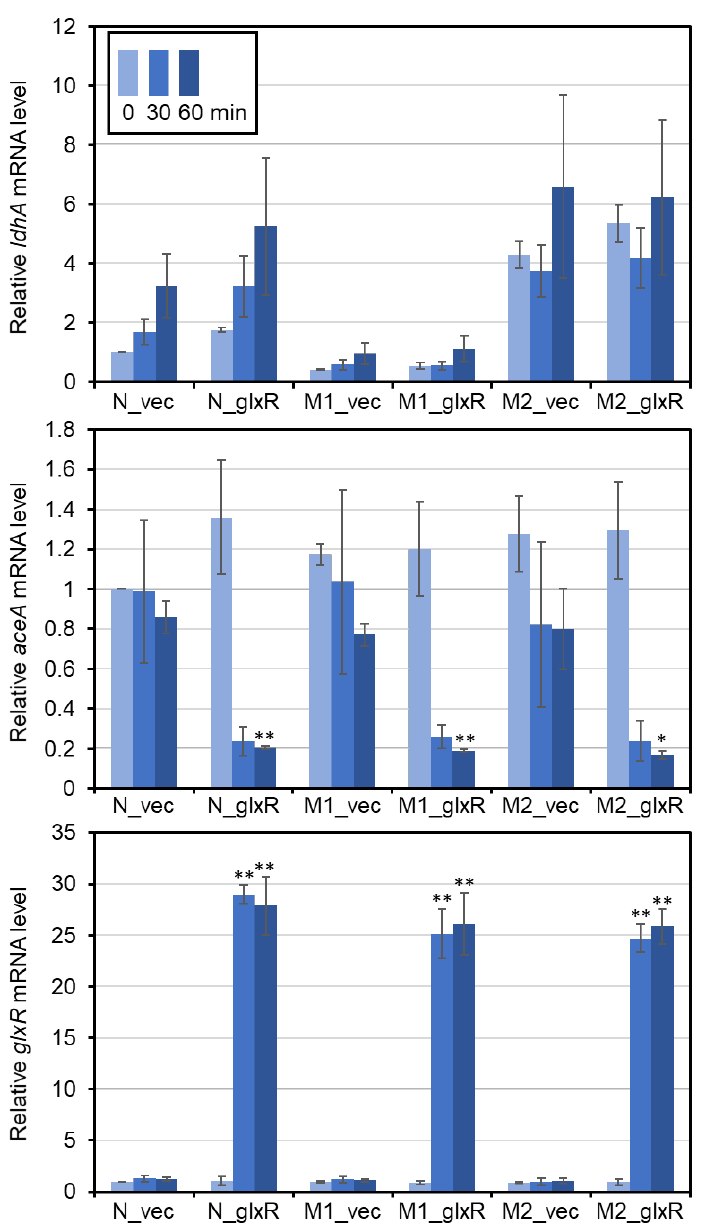
Figure 5. Overexpression of glxR elicited a positive effect on ldhA expression. The sugR – lldR deletion mutants harboring the native (N), mut1 (M1), or mut2 (M2) GlxR-binding site in the ldhA promoter were transformed with either the control vector pCRB12iP (vec) or the plasmid pCRC663 for glxR overexpression (glxR) and were induced with 0.5 mM isopropyl β - D -1-thiogalactopyranoside for 30 and 60 min at the exponential growth phase (3 h from the beginning of cultivation). The transcript levels of the ldhA (top), aceA (middle), and glxR (bottom) genes were determined by quantitative reverse-transcription polymerase chain reaction analysis. Transcript levels in the wild type carrying the vector before induction were standardized to 1. Mean values obtained from three independent cultivations are shown with their standard deviations. p -values were calculated using an unpaired t -test. (*) p < 0.05; (**) p < 0.01 (comparison of glxR overexpression strains with vector strains at the same sampling points). The mutations in the GlxR-binding site in the ldhA promoter region altered ldhA ex- pression. The effects of this modification of the expression on organic acid excretion were